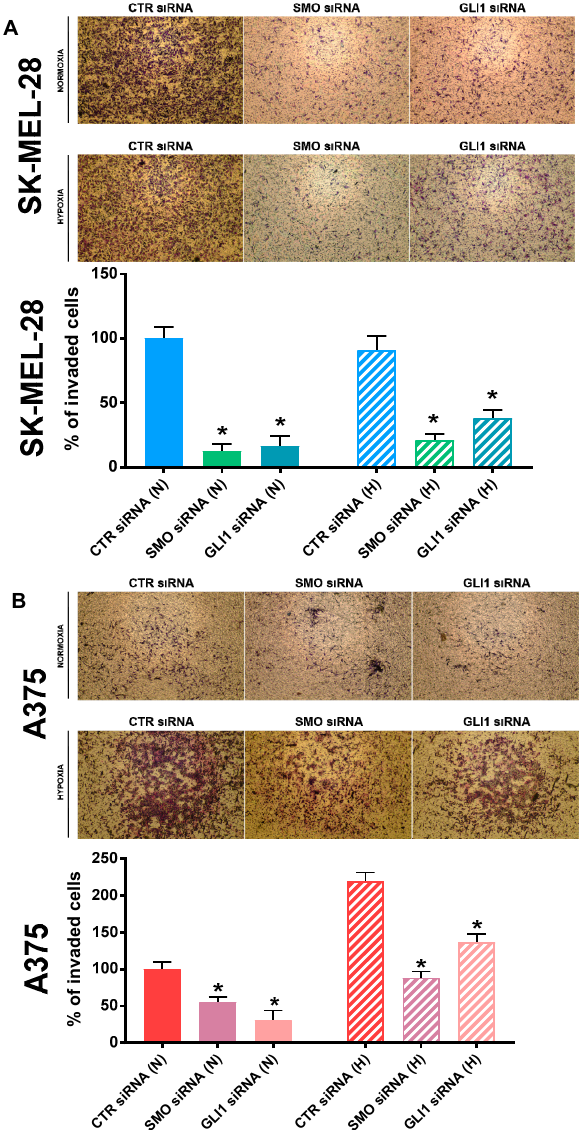
Figure 7. SMO and GLI1 transient knockdown impaired melanoma cell invasion. Cell invasion measured by modified Boyden chamber assay in SK-MEL-28 ( A ) and A375 ( B ) cells silenced with SMO and GLI1 siRNAs under normoxic (N) and hypoxic (H) conditions. Pictures are representative of three independent experiments. Means ± SEM are presented. (n = 3; * p ≤ 0.05 indicates statistically significant difference).